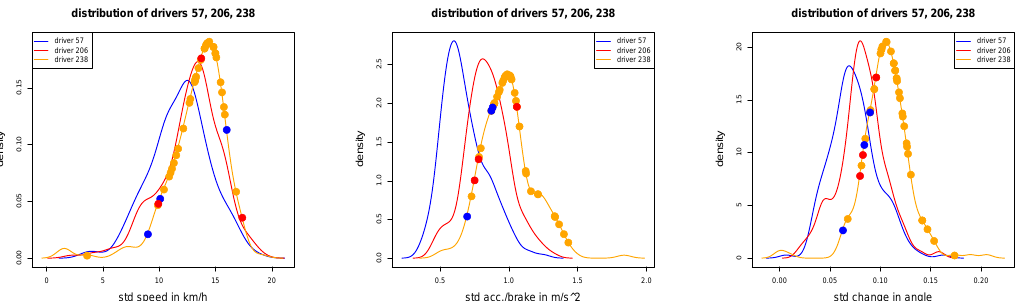
Figure 8. Out-of-sample analysis of the 42 test samples of driver 57: correctly classified trips (blue dots) and misclassified trips (red and orange dots according to the given labels) of driver 57, illustrated in the density plots of σ v , s , σ a , s and σ ∆ , s for s = 1, . . . , S .